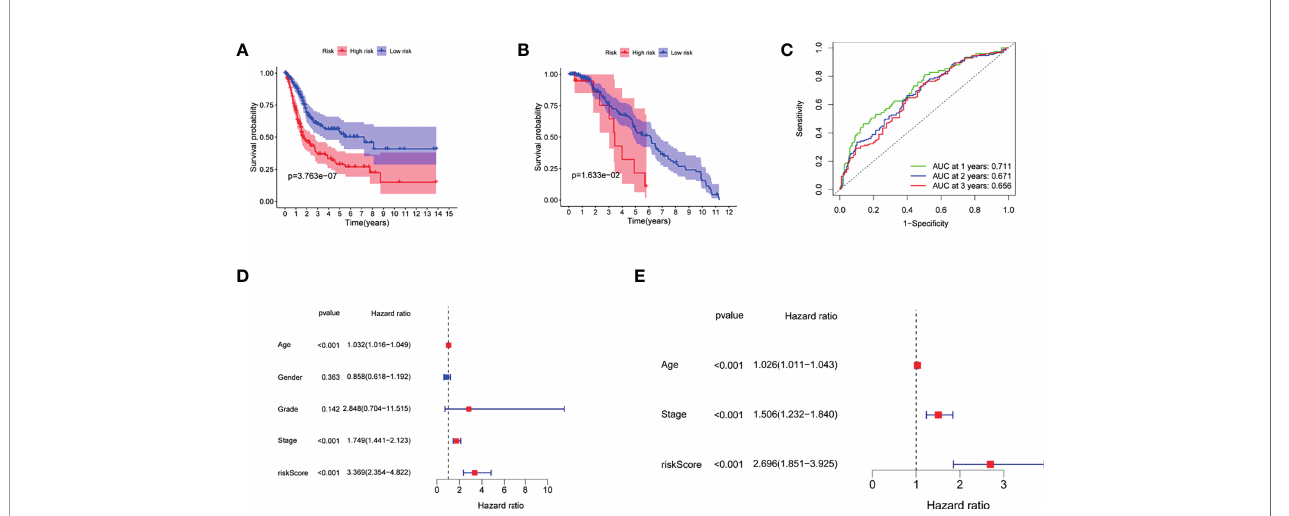
FIGURE 4 | The role of the risk score in overall survival. (A) Kaplan – Meier curves for OS of patients in the high- and low-risk groups of TCGA. (B) Kaplan – Meier curves for OS of patients in the high- and low-risk groups of GEO13507 cohort. (C) AUC time-dependent ROC curves for OS in TCGA. (D) OS-related factors were screened by univariate cox regression analyses in TCGA. (E) OS-related factors were screened by multivariate cox regression analyses in